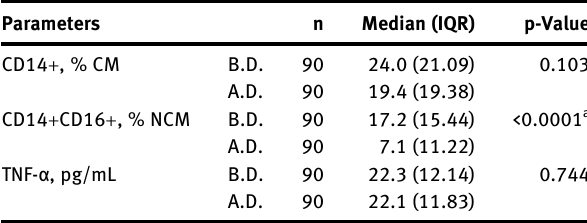
Table  : MonocytesubgroupratiosandserumTNF- α levelsinbefore and post dialysis